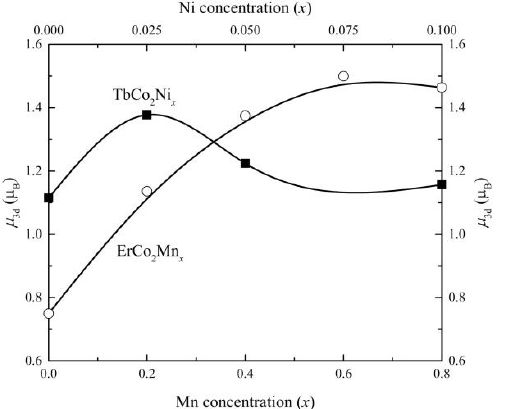
Fig. 5. Concentration dependences of the magnetic moment of 3 d -sublattice for ErCo 2 Mn x ( ○ ) and TbCo 2 Ni x ( ■ ) compounds.